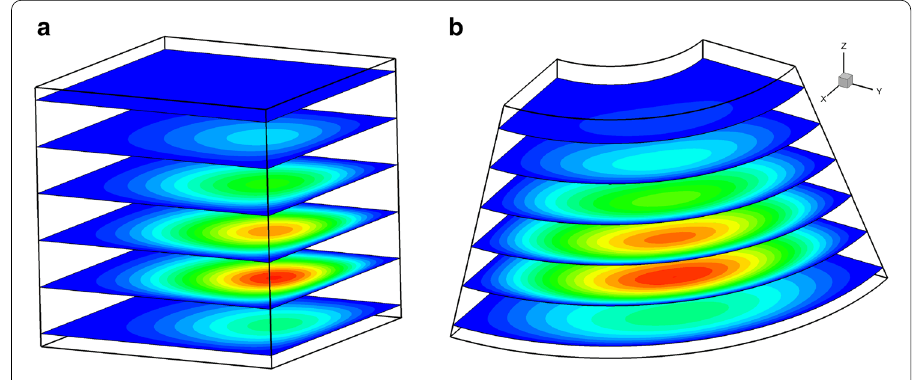
Fig. 12 Temperature field: a Computational domain; b Physical domain